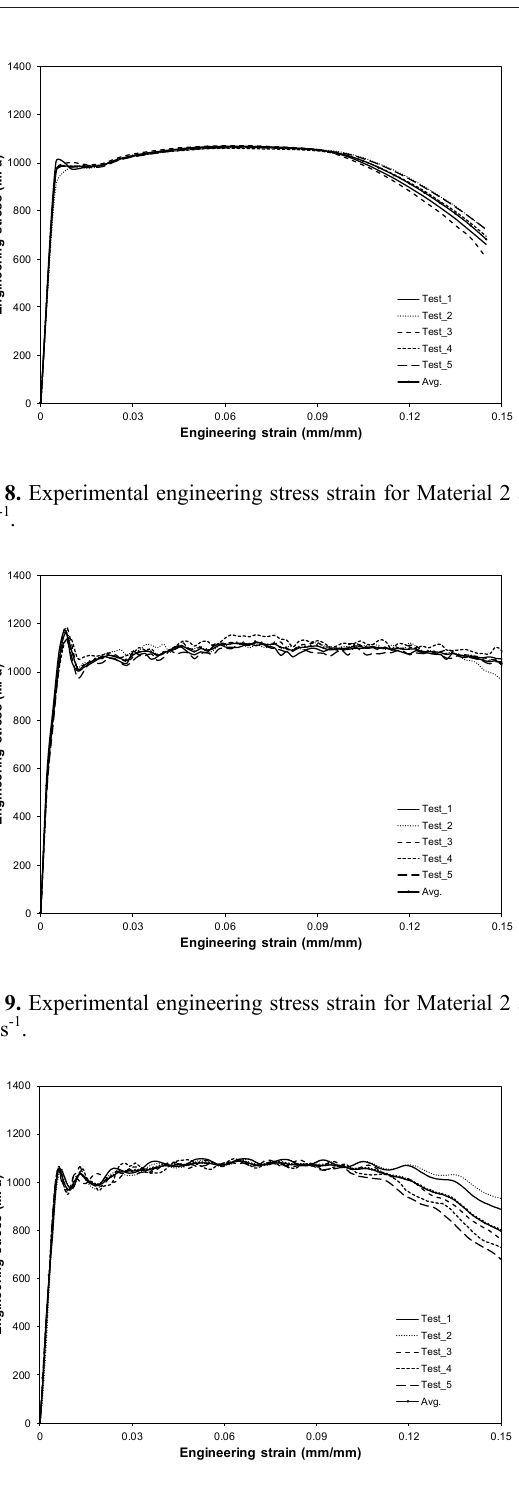
Fig. 10. Experimental engineering stress strain for Material 2 at 1,000 s -1 .